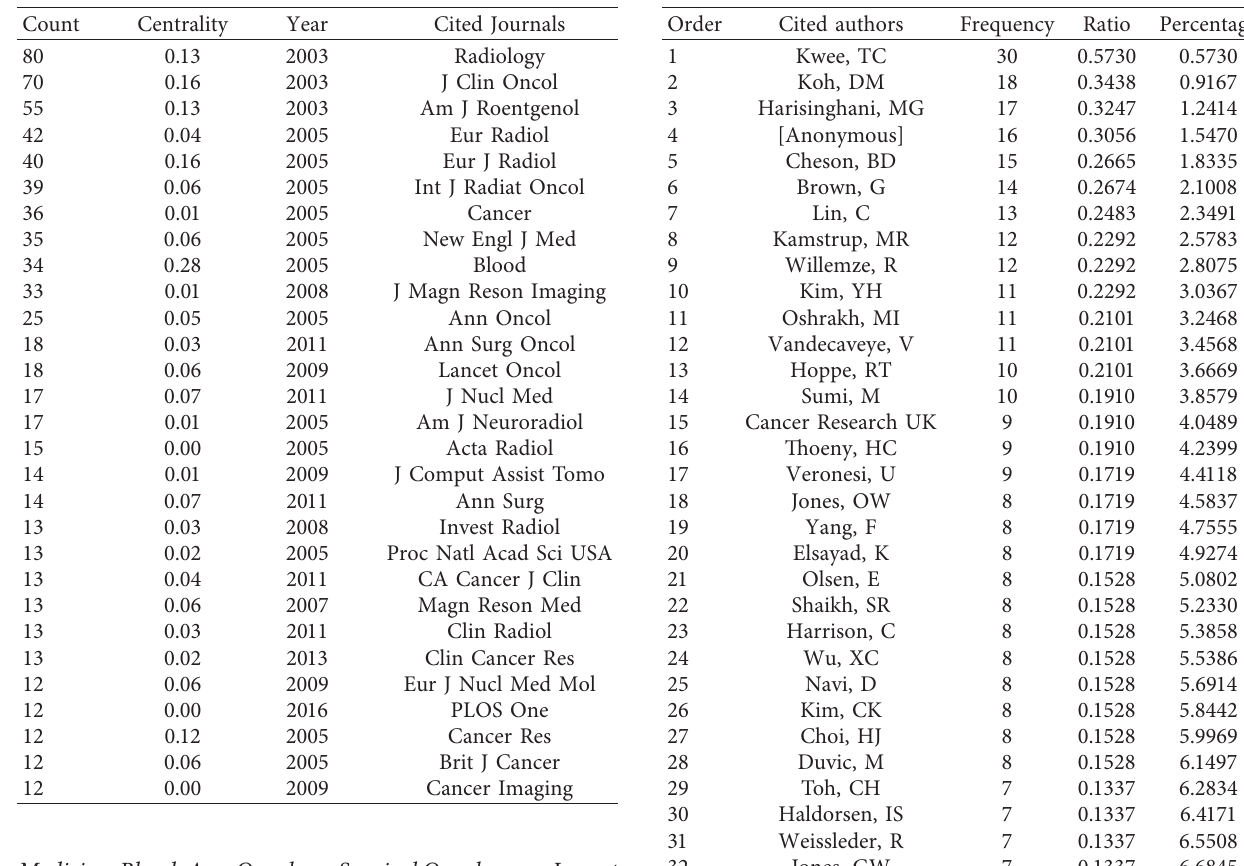
Table 6: The list of journals. Table 7: The list of cited